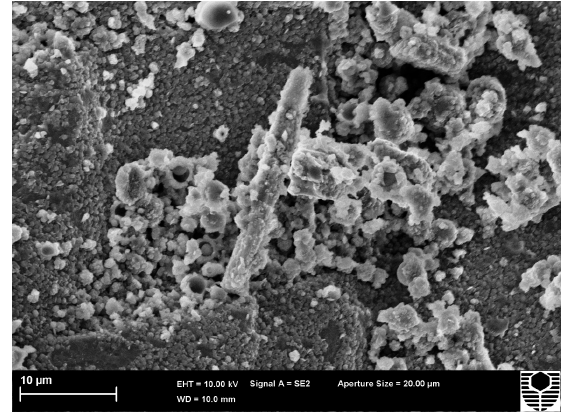
Figure 7. HTC 6A as cured (AC) fracture surface image.